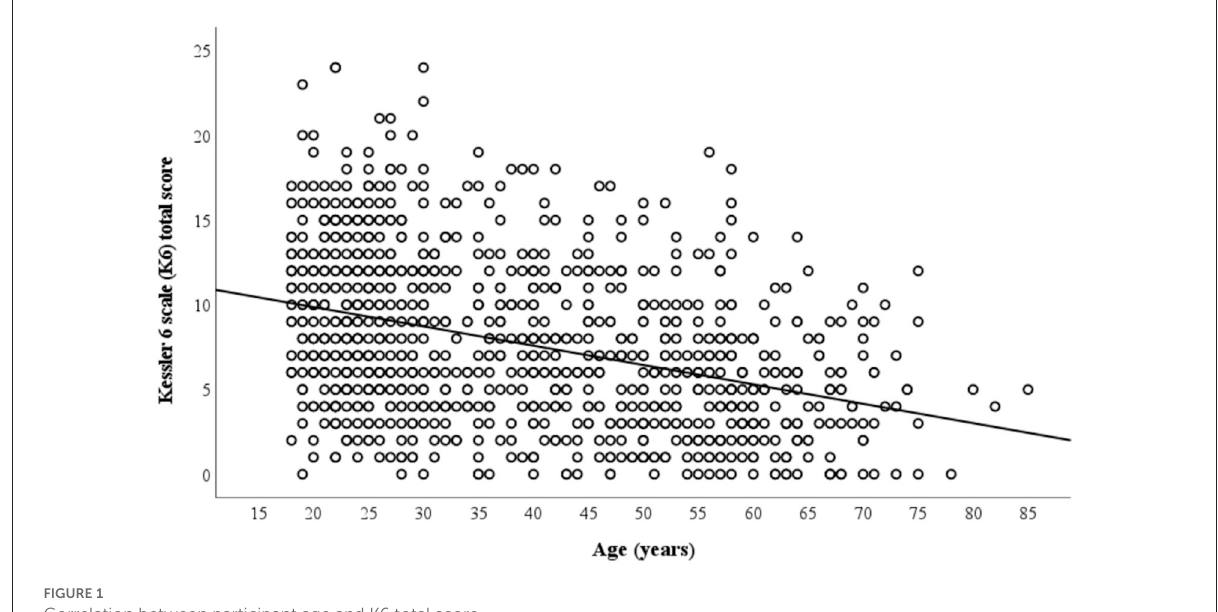
FIGURE1 Correlation between participant age and K6 total score.